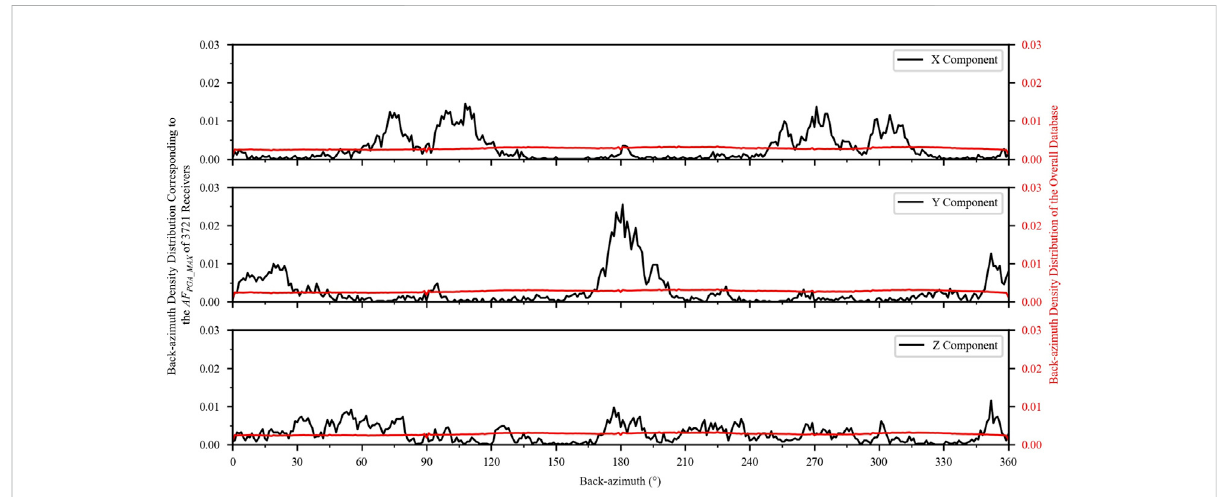
FIGURE 4 The density distribution of back-azimuth. The black solid line represents the density distribution of the back-azimuth corresponding to the AF PGA MAX of 3,721 receivers (From top to bottom: the X, Y, and Z components, respectively); the solid red line represents the back-azimuth density distribution of the overall